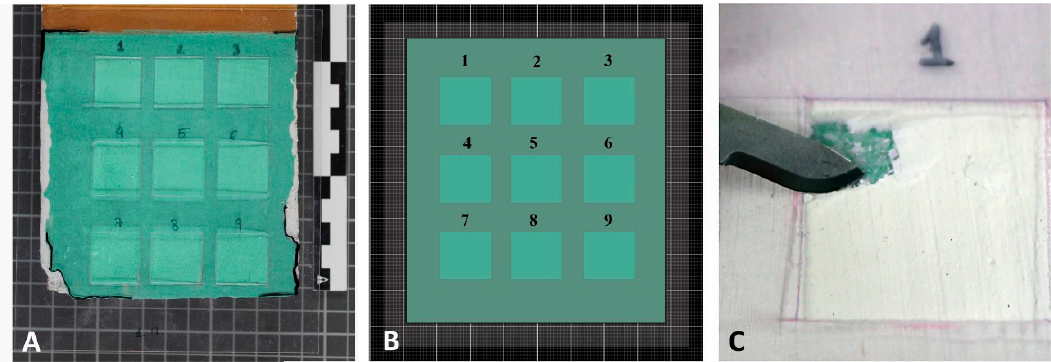
Figure 3. ( A ) Image of Probe 1 in its initial stage with the acetate template that shows the gaps where the different cleaning processes will be applied. ( B ) Two-dimensional and simplified simulation of Probe 1 and how the gaps of the acetate template created for the cleaning tests are distributed. ( C ) Mechanical cleaning process with a scalpel.